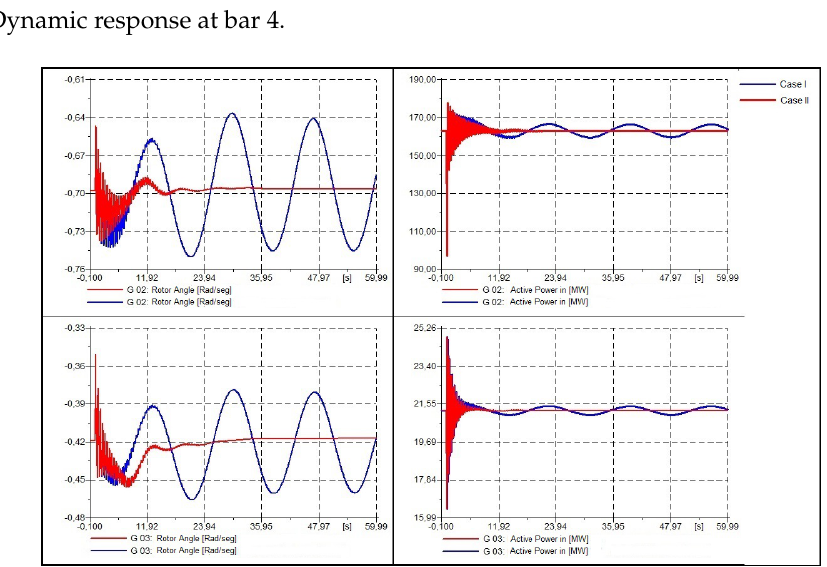
Figure 11. Rotor angle [rad] and Active Power [MW]-three phase fault at bus 4. 2. Dynamic response at bus